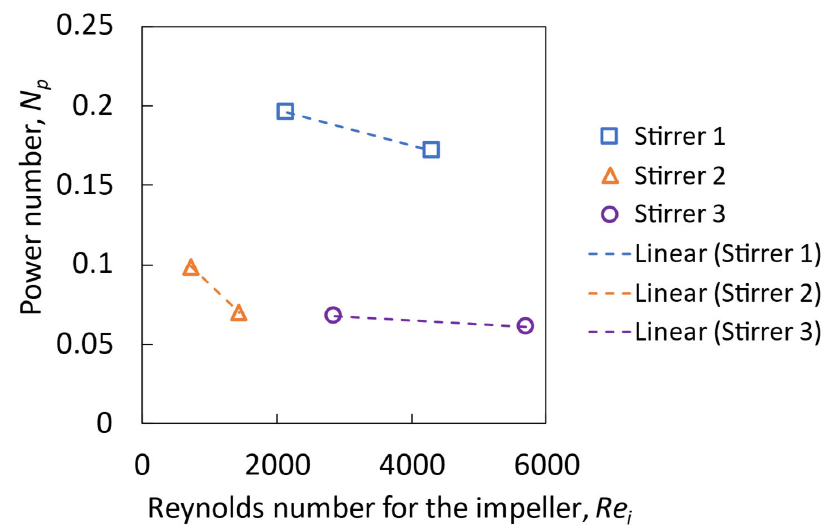
Figure 13. Power number as a function of the impeller Reynolds number derived from the simulation results.